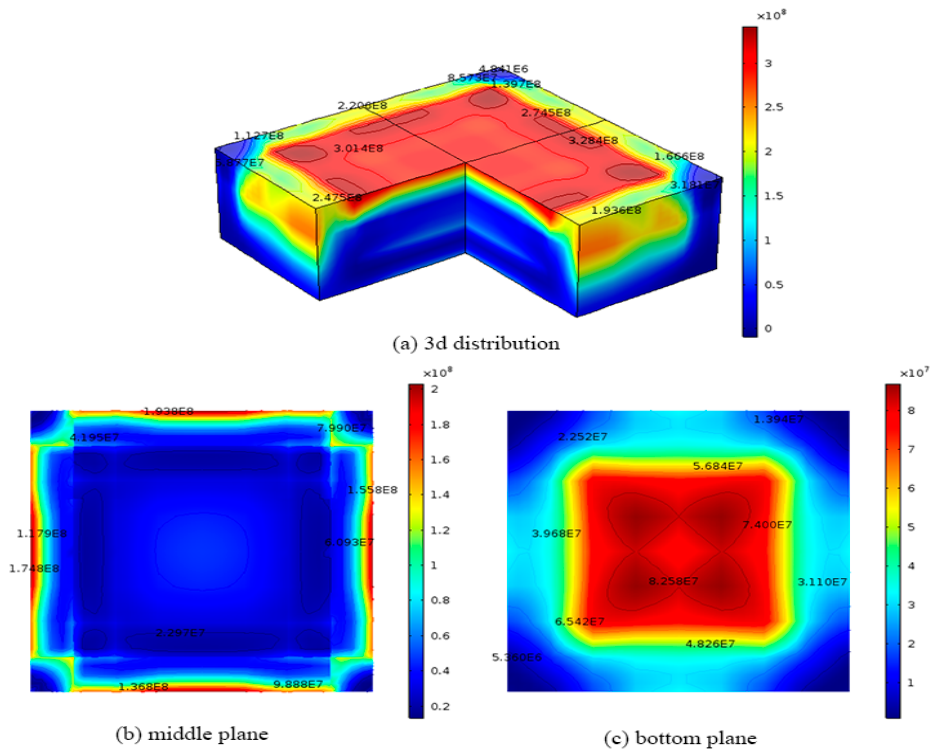
Figure 6. Dislocation density distributions of 0.84 m × 0.84 m × 0.3 m ingot at the end of the cooling process obtained from Hassen model with the modified cooling process ( a ) 3D distribution; ( b ) middle plane; ( c ) bottom plane. Materials 2019 , 12 , x FOR PEER REVIEW